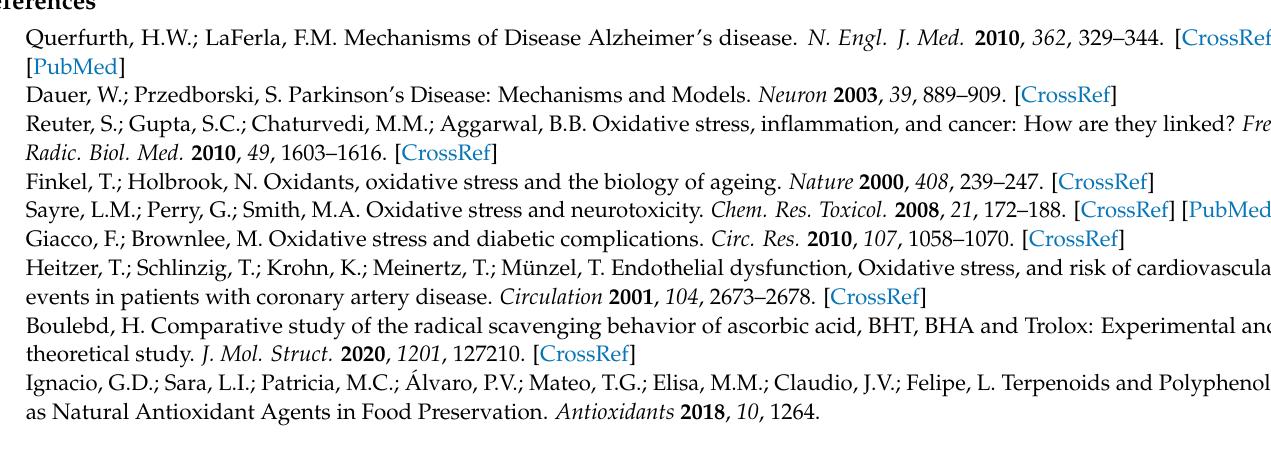
Figure S4: HMBC Spectrum (600 MHz) of Fr4-1-1 (in MeOD- d 4 ). Figure S5: ESI mass spectrum of Fr4-1-2. Figure S6: 1 HNMR Spectrum (600 MHz) of Fr4-1-2 (in MeOD- d 4 ). Figure S7: 13 CNMR Spectrum (600 MHz) of Fr4-1-2 (in MeOD- d 4 ). Figure S8: HMBC Spectrum (600 MHz) of Fr4-1-2 (in MeOD- d 4